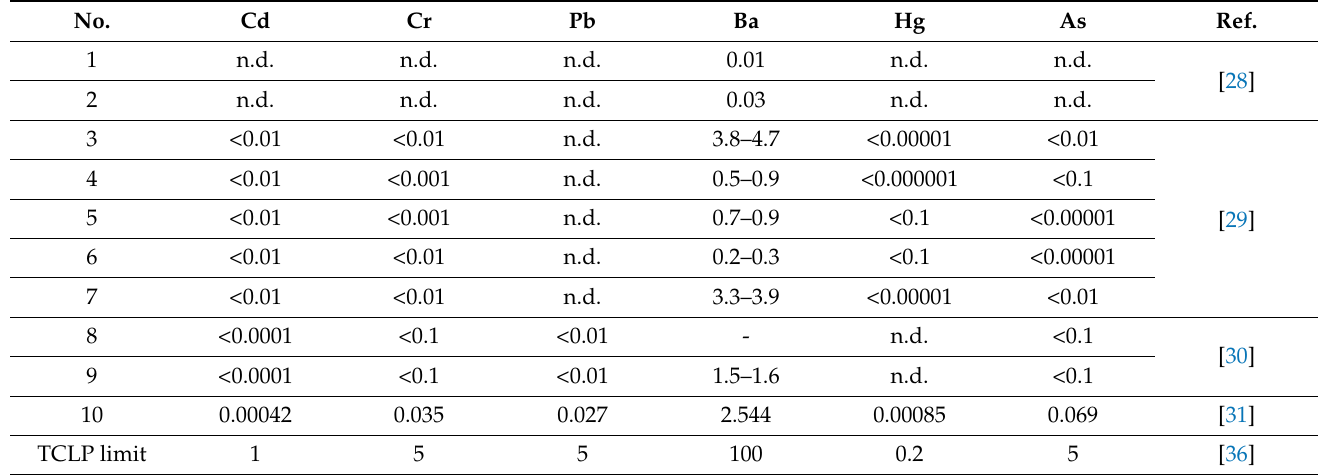
Table 2. Leaching results of heavy metals from CFA in some literatures